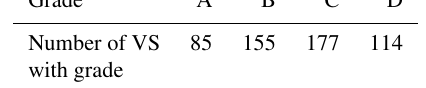
Table 2. Qualitative letter grade summary.